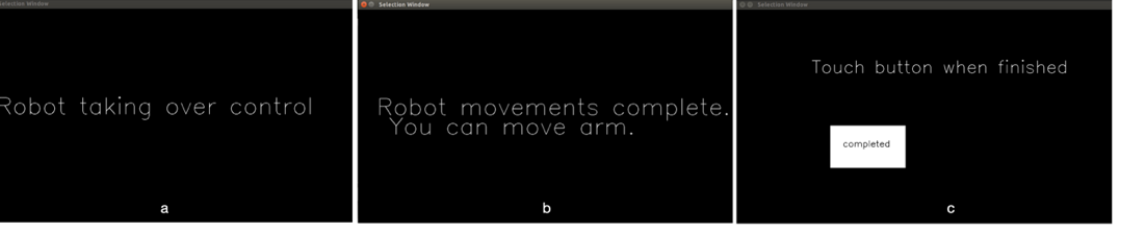
Figure 4. Messages displayed on GUI. Subfigure 4a is the message displayed on the touchscreen during the Autonomy state. Subfigure 4b is displayed once autonomous control has finished and transitions to the user controlled Teleop Free state. Subfigure 4c is the message displayed during Teleop in Task where the system waits until the user is done with a temporal operation ( i.e., filling the cup with water, or drinking from the cup ) before transitioning back to Autonomy.